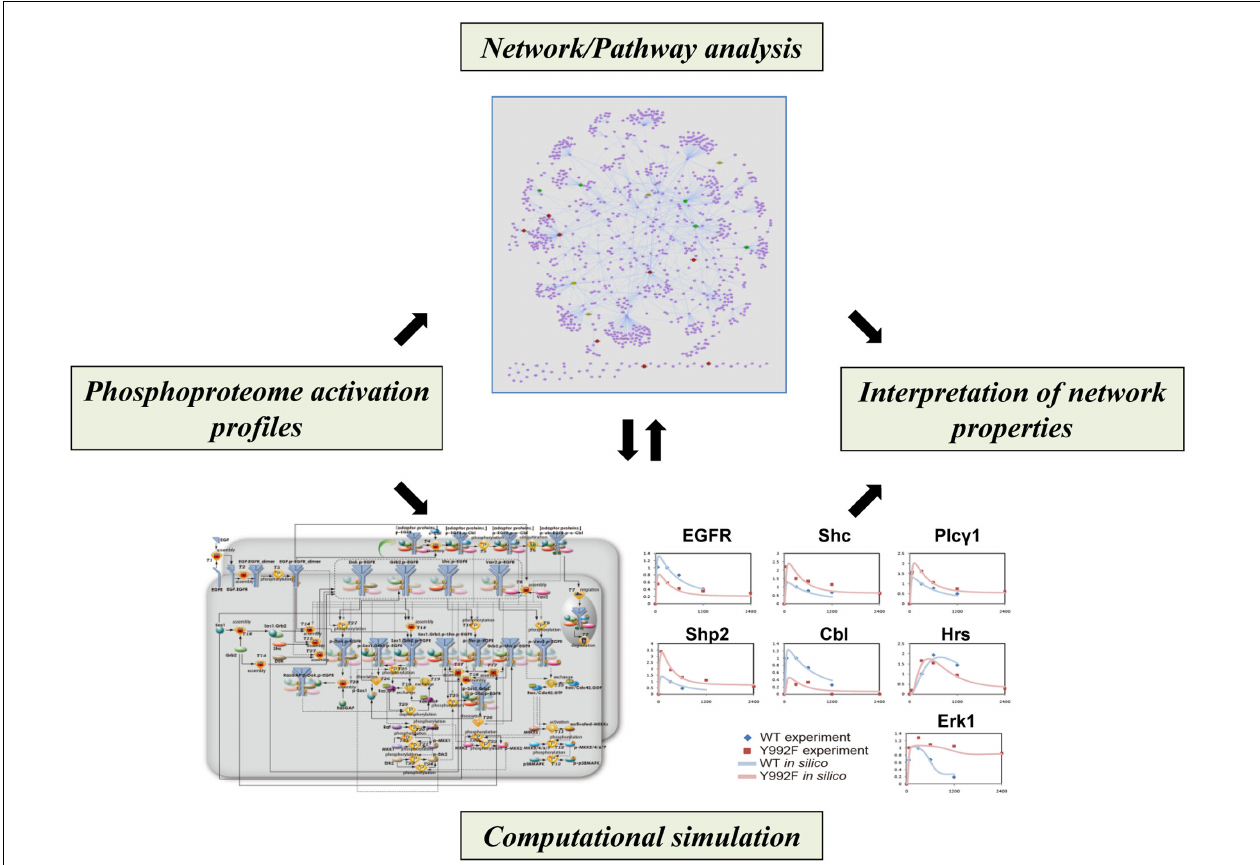
FIGURE 3 | Computational approaches for analyzing network properties of phosphorylation-dependent signaling behavior. Phosphoproteomics-based network models, in combination with literature-based network/pathway information, can be sophisticated to interpret regulatory aspects of signaling